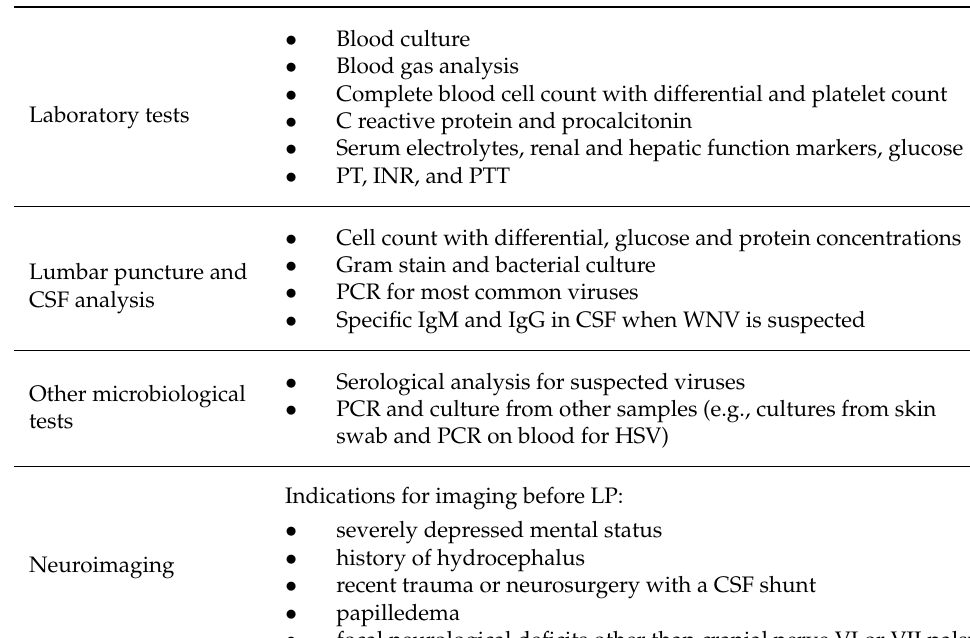
Table 1. Laboratory, microbiological and imaging evaluations for suspected central nervous system (CNS)